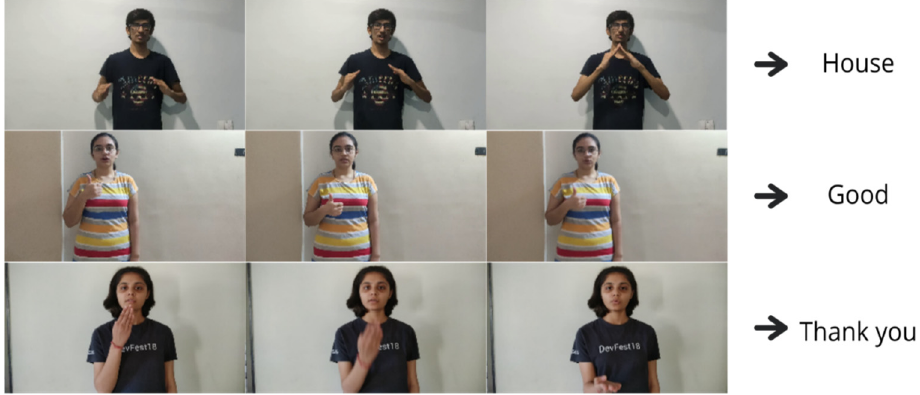
Figure 4. Samples from the custom Indian Sign Language (ISL) dataset (IISL2020).